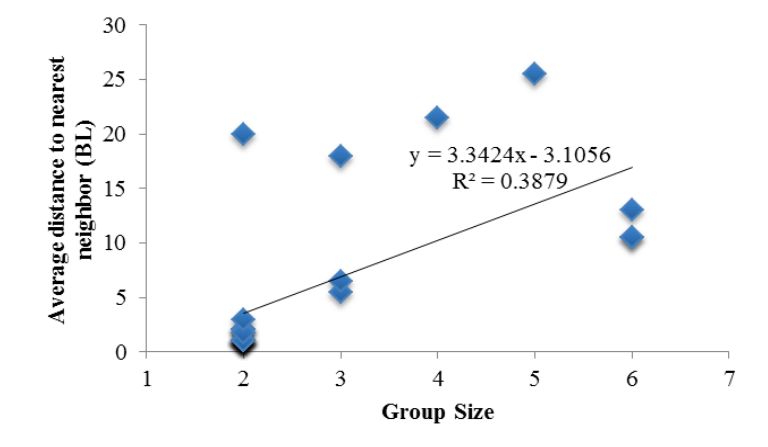
Figure 3. Blue whale cohesion by group size.